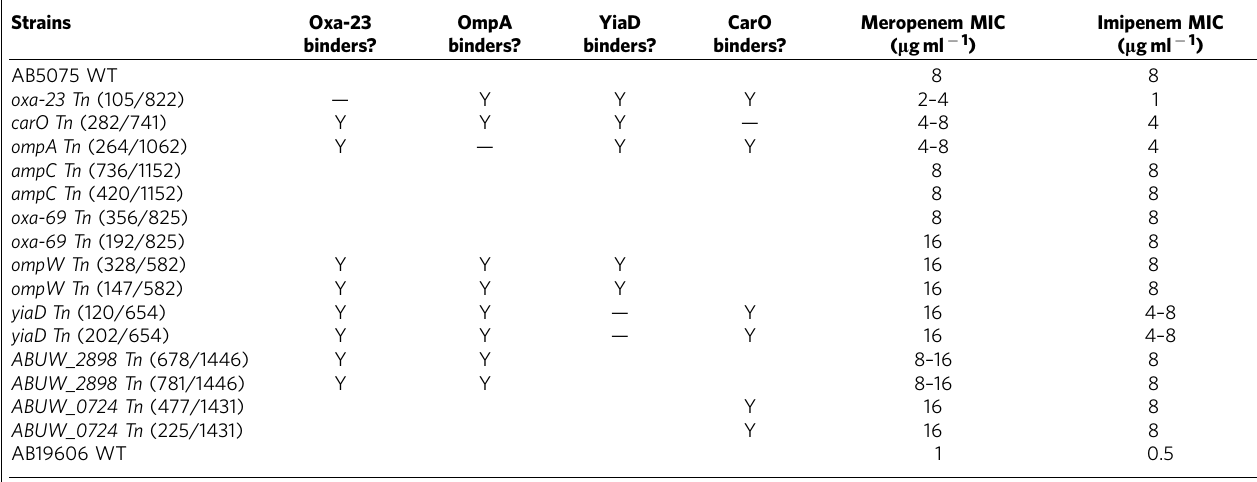
Table 1 | MIC for AB5075 transposon